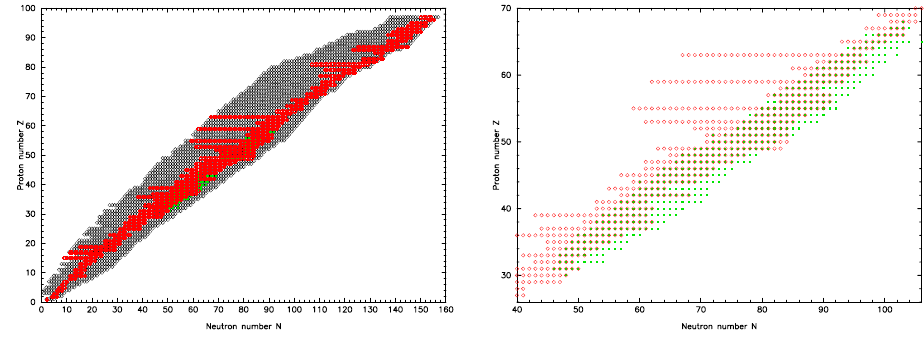
Figure 2. (Left) The ( N , Z ) domains included in the FIER data tables. The dark bins show the nuclides with branching ratios and half-lives included, while the overlaid red bins show those with information on beta-decays. Clearly there is beta-decay information available for far fewer nuclides. The ( N , Z ) distribution of the fission products from spontaneous fission of 252 Cf(sf) is shown by the green bins. It is apparent that most but not all of the nuclei of interest are contained in the FIER tables. (Right) Magnified views of the relevant parts of the ( N , Z ) plane for 252 Cf(sf). The half-life information is omitted because all fission fragments of interest are included. Note that the green symbols show the location of fission products from one million spontaneous-fission